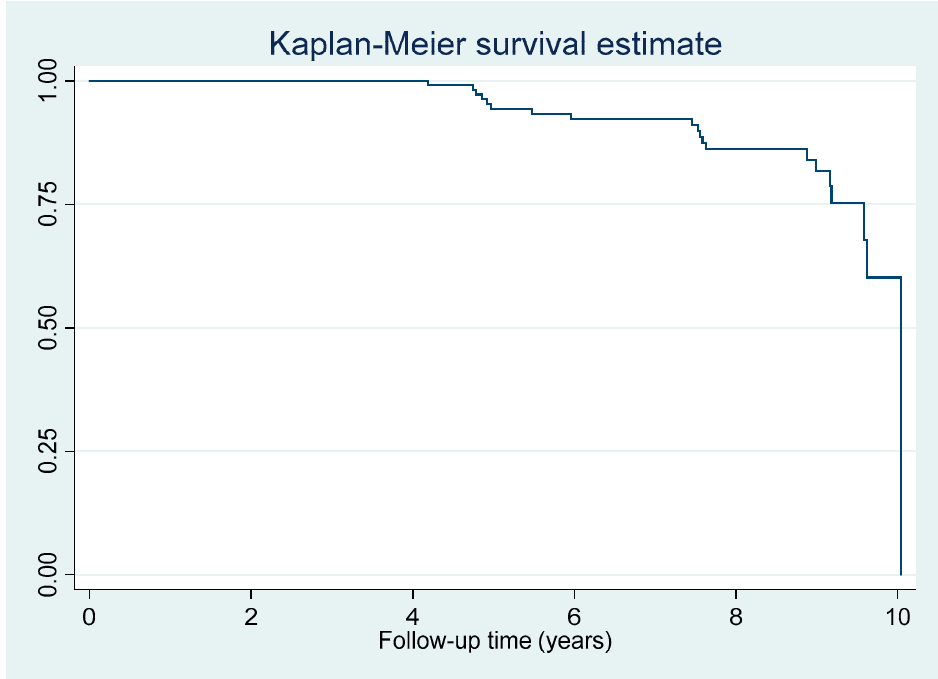
Figure 1. Kaplan–Meier survival curve of nonalcoholic fatty liver disease incidence in patients with metabolic syndrome.